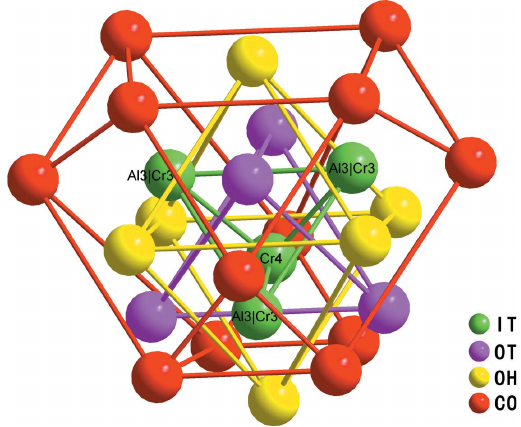
Figure 4 26-atom (cid:2) -brass-type cluster represented as a sequence of polyhedral